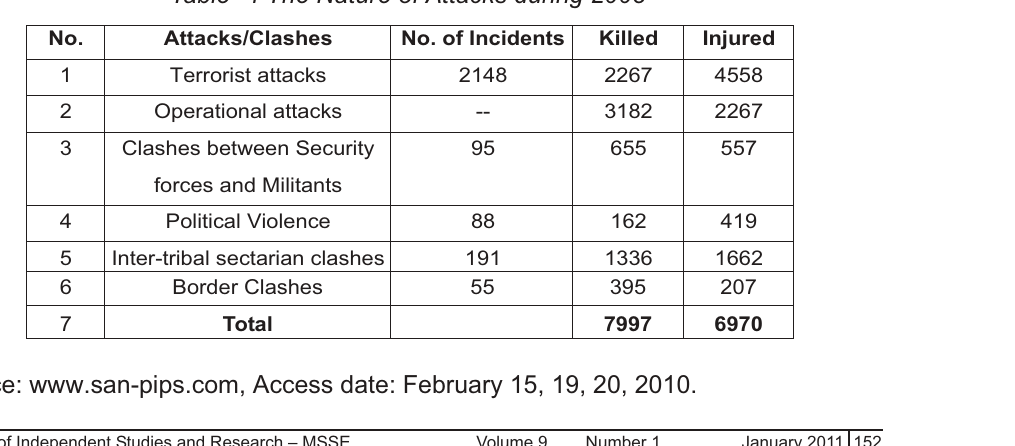
Table- 4 The Nature of Attacks during